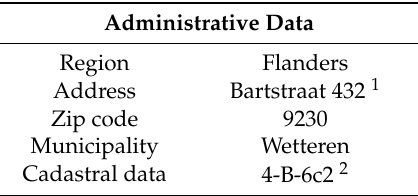
Table 3. Extracted administrative data out of the EPC.